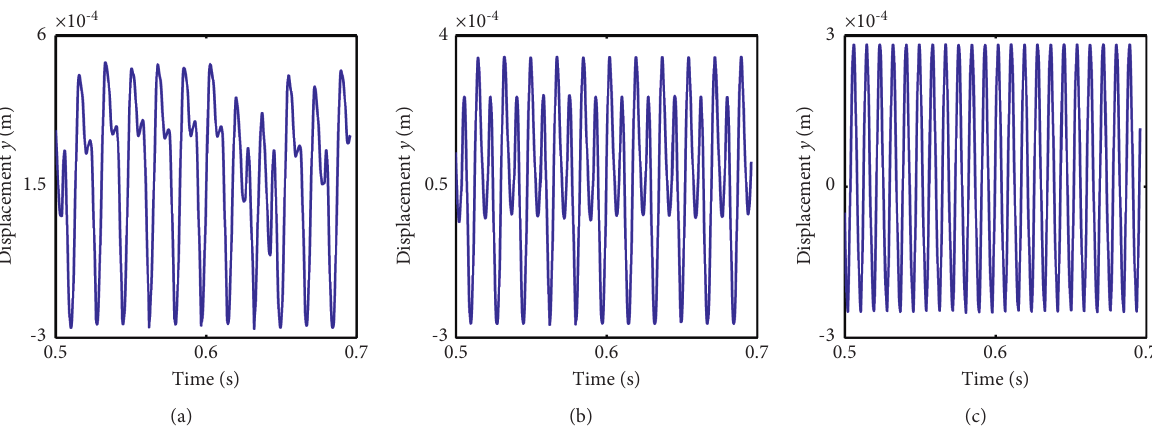
Figure 20: Vibration waveforms of the right journal with the change of the mass of the right bearing support. (a) m and (c) m 6 � 2